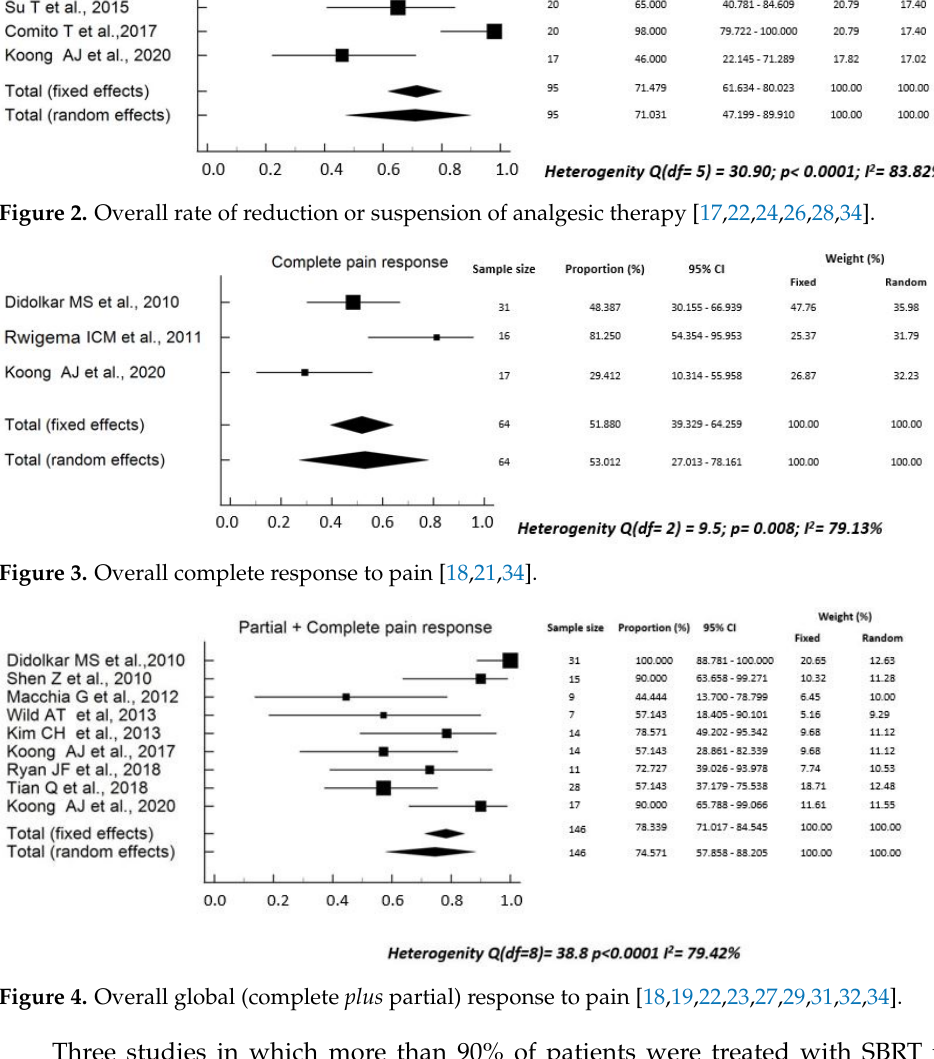
Figure 5. Linear regression: equivalent doses in 2-Gy fractions (EQD2) versus overall response rate of pain. 2.4. Pain-Free Survival Sixteen studies did not report on the pain control duration [17,19–29,31–34]. One study, which showed a worsening of pain 14 days after SBRT, showed that 50% of pa- tients had a reduction of this symptom three months after SBRT [16]. In another study, it was observed that patients with complete pain relief remained symptom free after six months [18]. Finally, another study confirmed that SBRT-induced pain reduction was stable after at least six months [30].